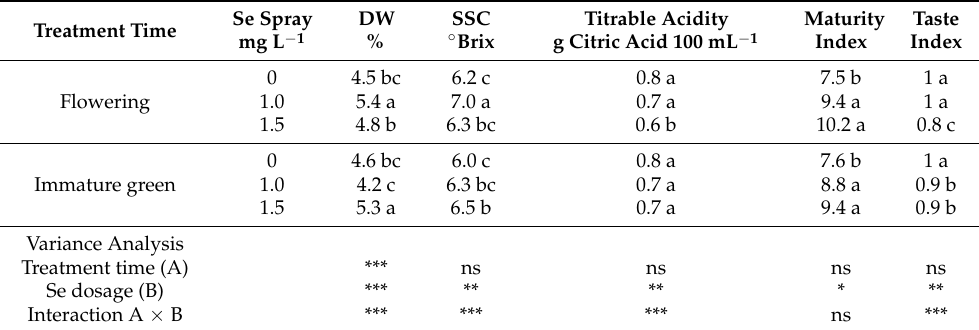
Table 6. Qualitative characteristics of tomato fruits of the second truss treated with sodium selenate (Na 2 SeO 4 ) at different concentrations of selenium and distributed at FL and fruit IG stages. Treatment